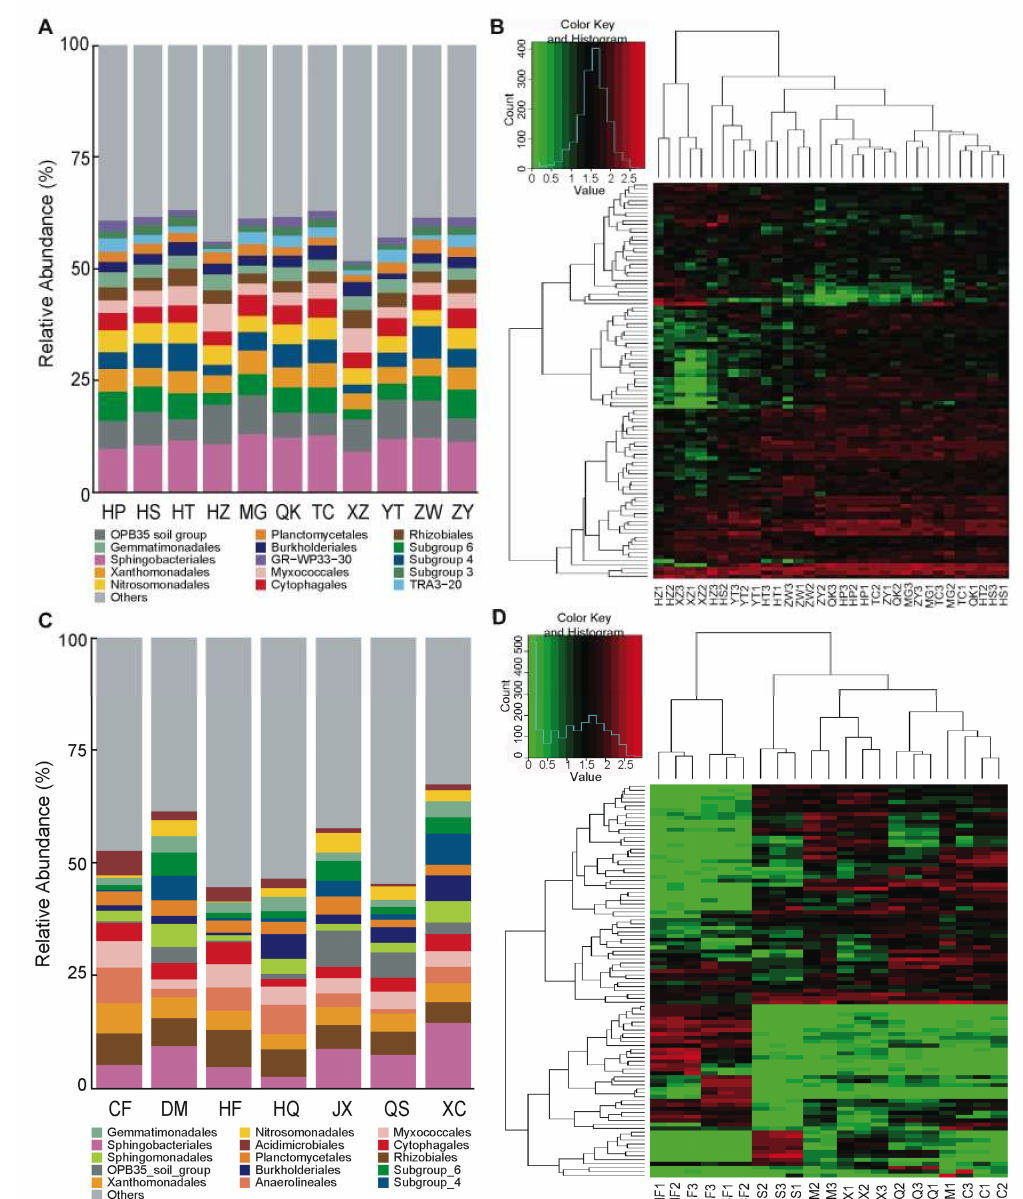
Figure 1. The composition and relative abundance of the major bacterial taxa and the 100 most abundant operational taxonomic units (OTUs) in the tomato rhizosphere microbiota. ( A , C ) The composition and relative abundance of major bacterial orders in tomato cultivar samples ( A ) or soil samples ( C ). Each bar represents the average value of three replicates in each sample group. ( B , D ) Heatmap depicting the 100 most abundant OTUs in the microbiota of tomato cultivar samples ( B ) or soil samples ( D ). Dendrogram links and distances between OTUs do not depict phylogenetic relationships; they are based on the number of reads (log-transformed) of OTUs within the samples. The legend and scale in the upper right corner of the Figure Show the colors in the heatmap associated with the relative abundance of OTUs (cluster of variables on the Y -axis) within each plant and soil sample ( X -axis clustering). Tomato cultivar experiment: Xinzhongshu No. 4 (XZ), Huangshoutao (HT), Tiancheng (TC), Meiguodahong 168 (MG), Huapiqiu (HP), Huangshengnvguo (HS), Huangzhenzhu (HZ), Qiaokeli (QK), Yingtao (YT), Ziwucai (ZW) and Ziyixiannv (ZY); soil experiment: commodity organic nutritional soil (CF), potted plant nutrient soil (HF), vegetable field soil (DM), agricultural field soil (HQ), campus lawn soil (JX), forest soil (QS) and garden soil